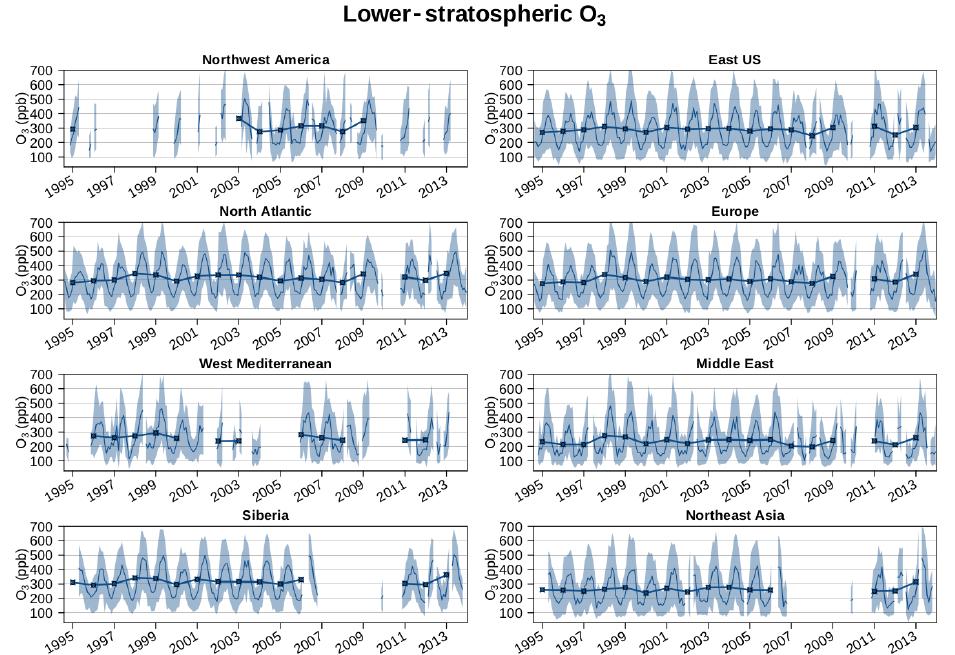
Figure B3. O 3 monthly mean values in the LS (thin curve). The interval from 5th and 95th percentiles is filled in blue. The yearly mean values are represented by the bold curve and the black points.